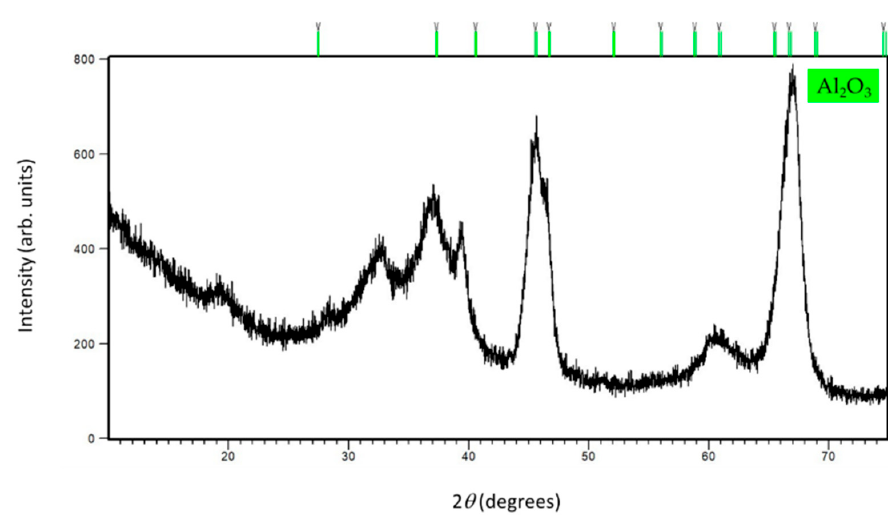
Figure 6. The final observed PXRD profile of alumina NPs at RT. The upper green tick marks show the reflection positions of the hexagonal Al 2 O 3 phase formation.